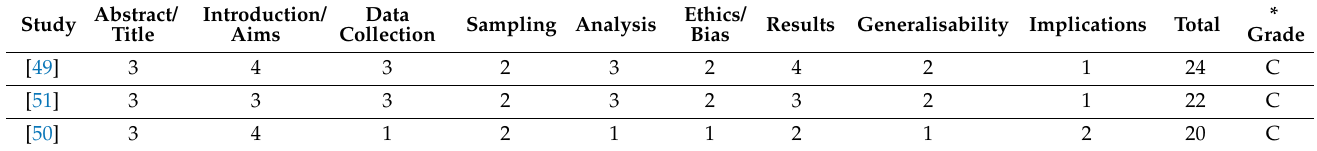
Table 3. Critical appraisal tool: Results of the quality assessment for the qualitative studies ( n = 3).